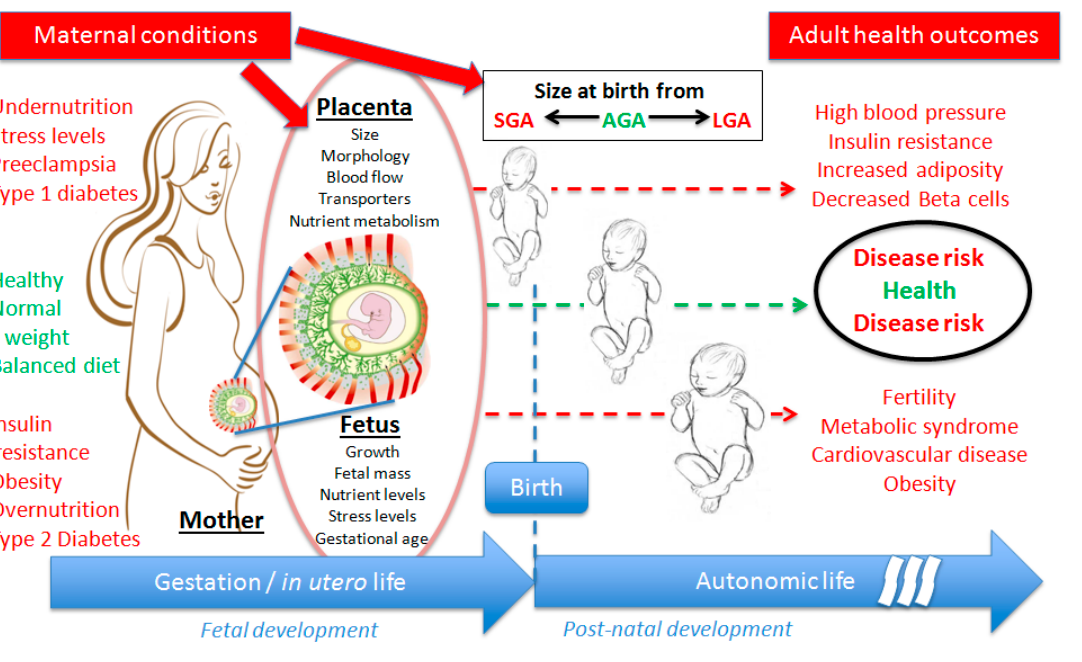
Figure 1. Schematic representation of the DOHaD (developmental origins of health and diseases) concept in human beings, showing the effects of several maternal conditions (non exhaustive) during the gestation on feto-placental unit development (affected parameters), leading to particular birth size from SGA (small for gestational age) to LGA (large for gestational age), and the most observed outcomes in terms of health at adulthood.